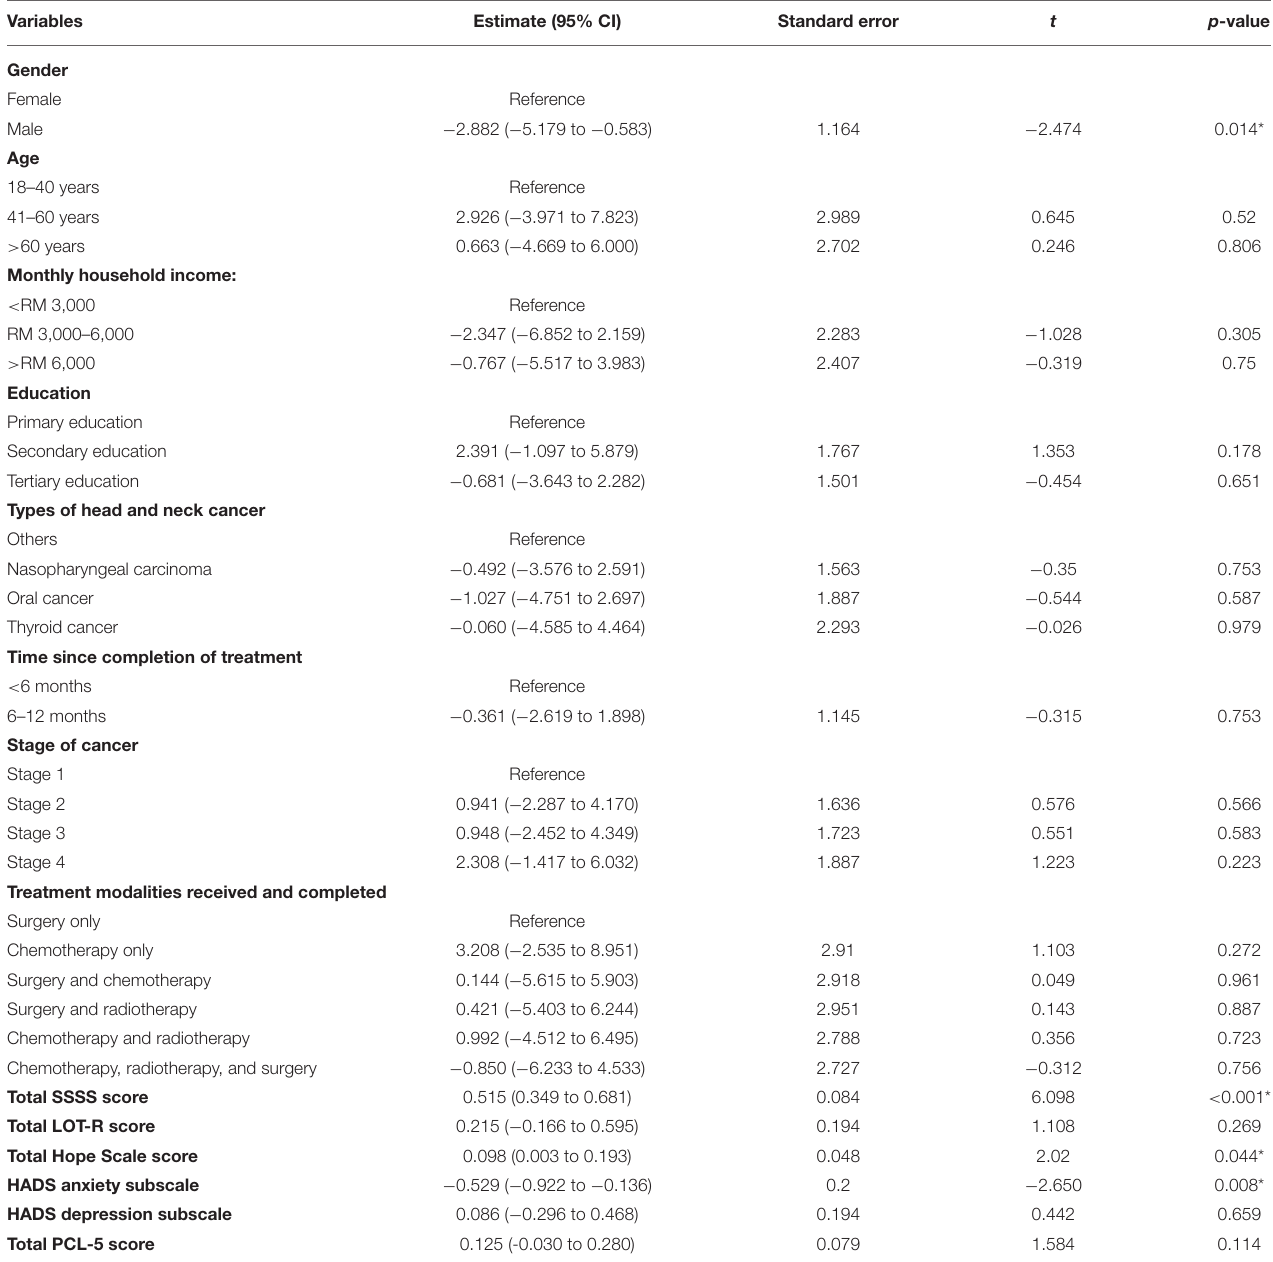
TABLE 3 | The random intercept model between the socio-demographic and clinical characteristics, total SSSS, total Hope Scale, total LOT-R, total PCL-5 scores, HADS subscale scores (independent variables), and total PTGI-SF scores (dependent